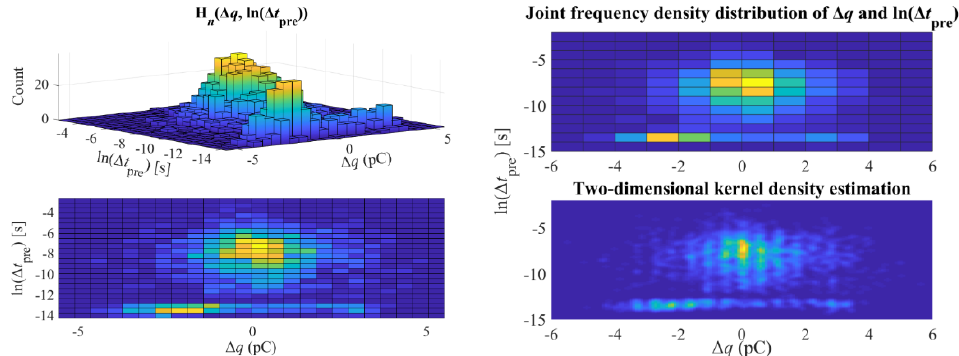
Figure 6. The illustration of H n ( ∆ q , ln( ∆ t suc )) and the corresponding result of two − dimensional Figure 6. The illustration of H n ( Δ q , ln( Δ t suc )) and the corresponding result of two − dimensional ker- Figure 6. The illustration of H n ( Δ q , ln( Δ t suc )) and the corresponding result of two − dimensional ker- Figure 6. The illustration of H n ( Δ q , ln( Δ t suc )) and the corresponding result of two − dimensional ker- nel density estimation. kernel density estimation. nel density estimation. nel density estimation.